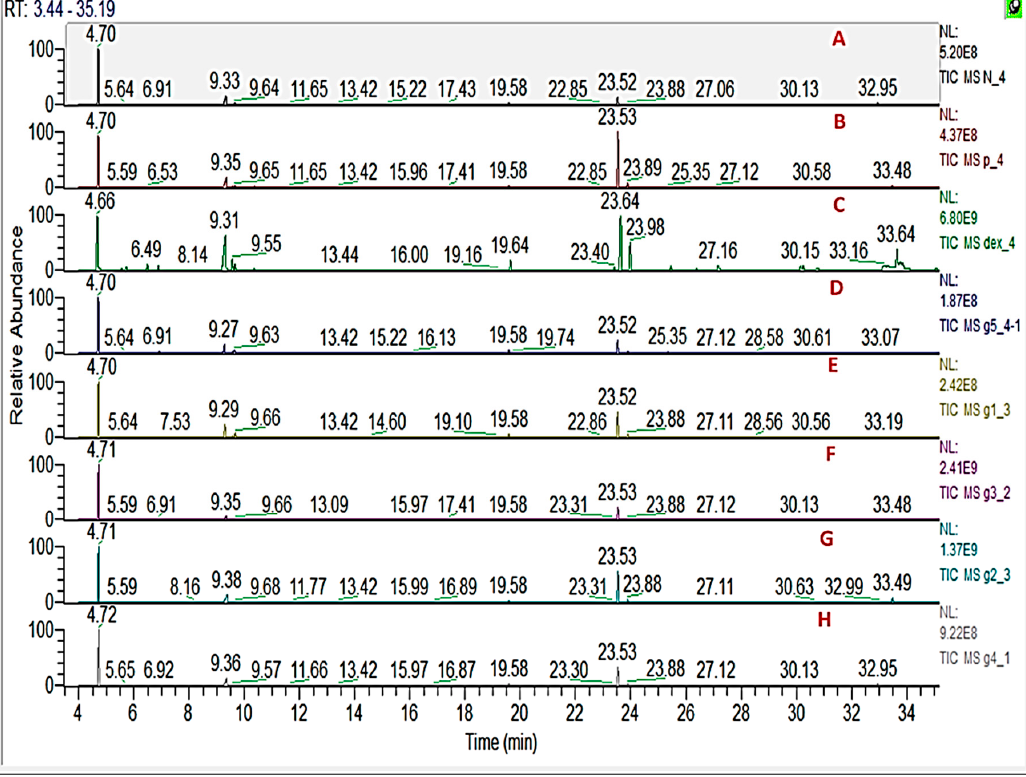
Figure 6. Representative GC/MS chromatograms of serum derived from ( A ) negative control, ( B ) positive control, ( C ) dexamethasone standard, ( D ) nano-Ag, ( E ) ASBE, ( F ) ASBE plus nano-Ag, ( G ) ASB nano-extract, and ( H ) ASB nano extract plus nano-Ag.